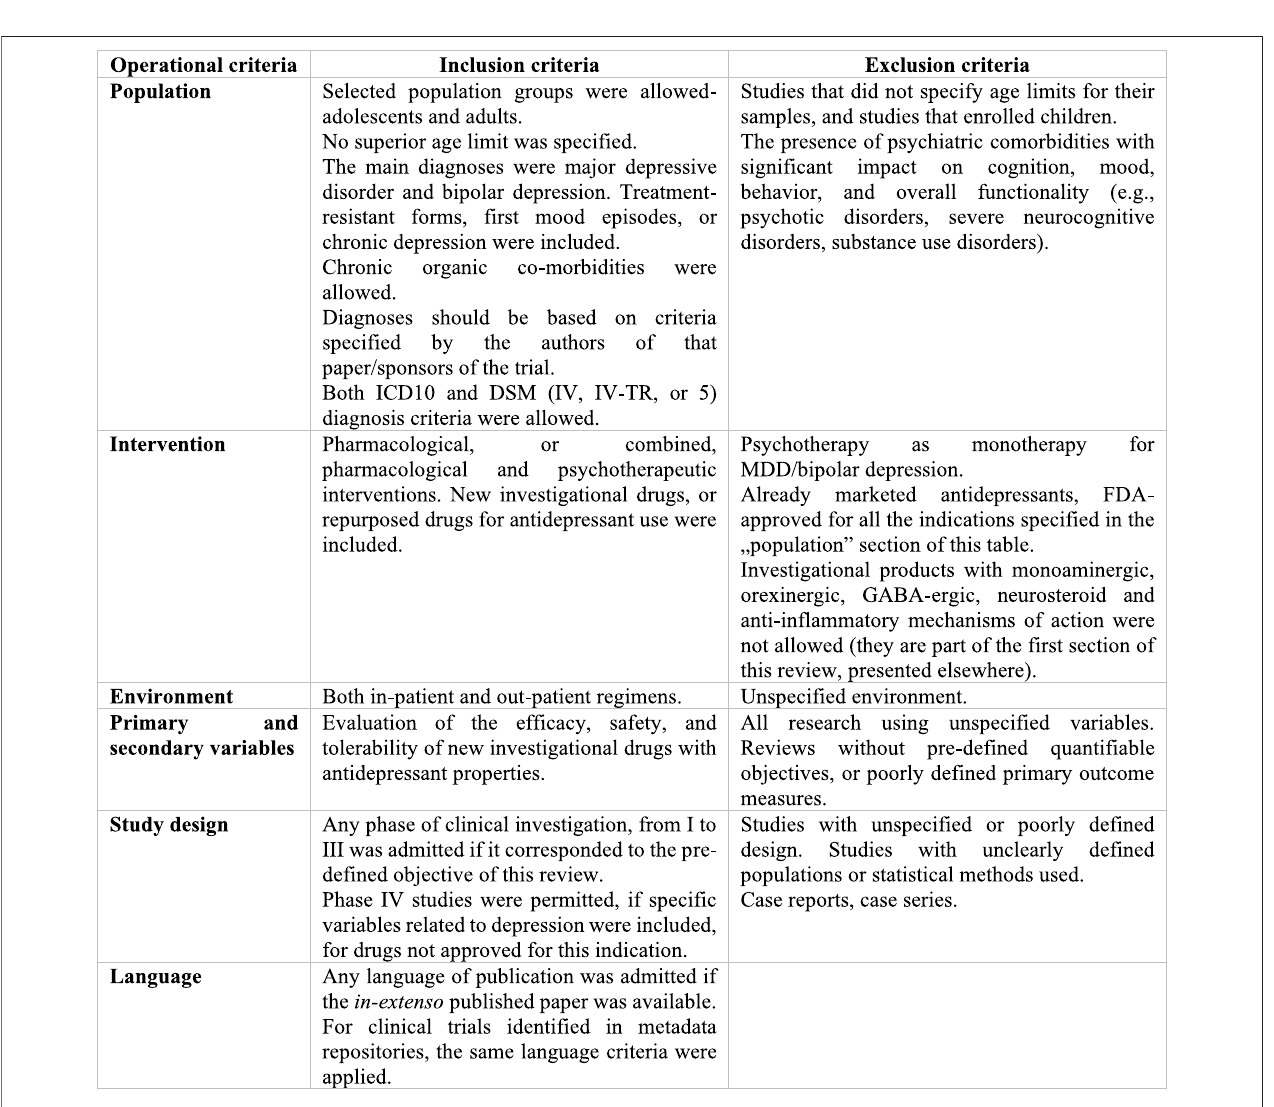
FIGURE 4 | Inclusion and exclusion